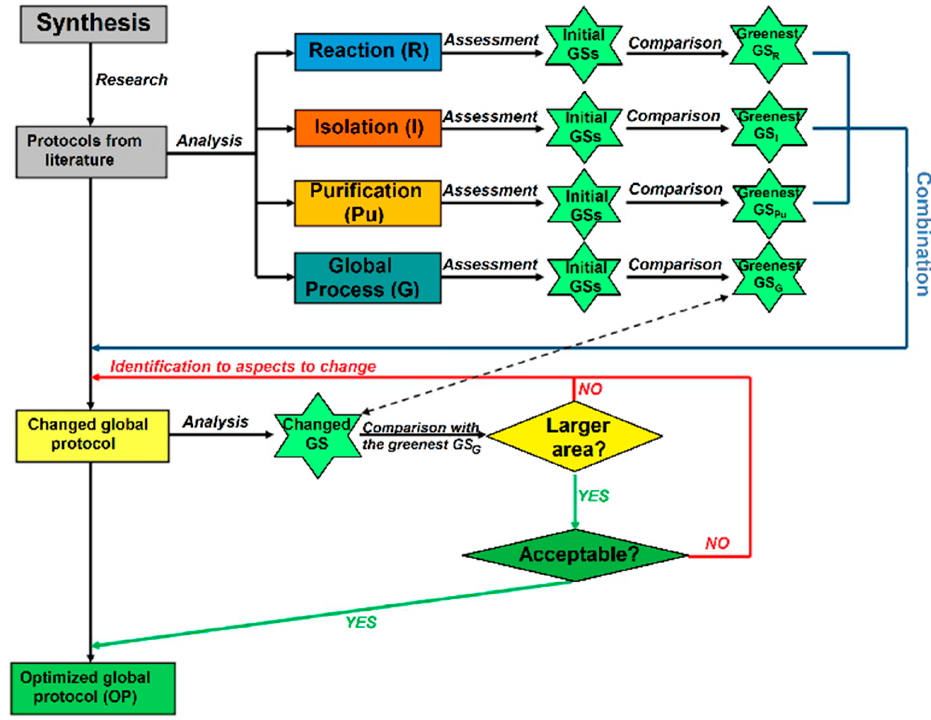
Figure 15. GS procedure considering all the steps in the synthesis. Adapted from Ref.